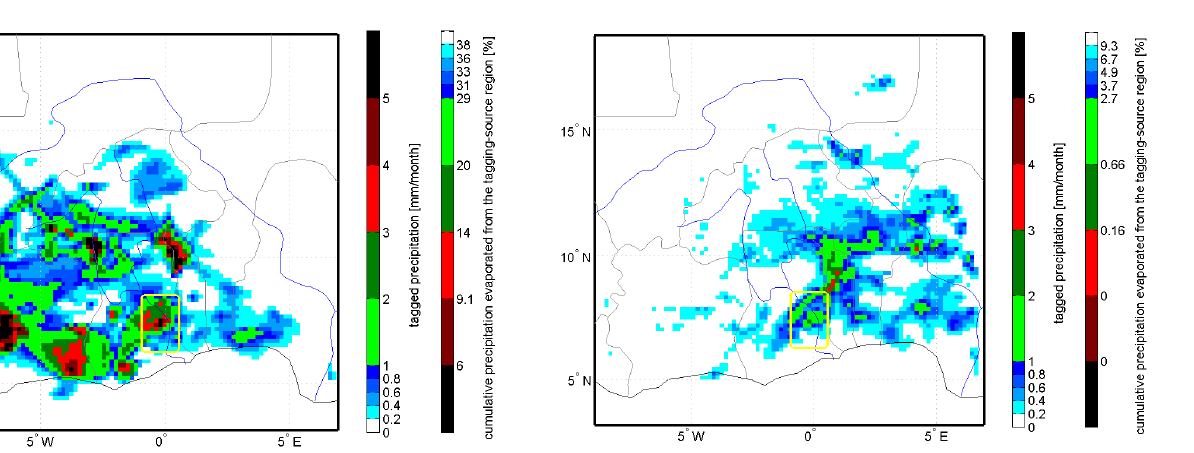
Fig. 4. Precipitation of Volta origin in August 1998 as computed by WAM. See Fig. 3 for an explanation of the colours.